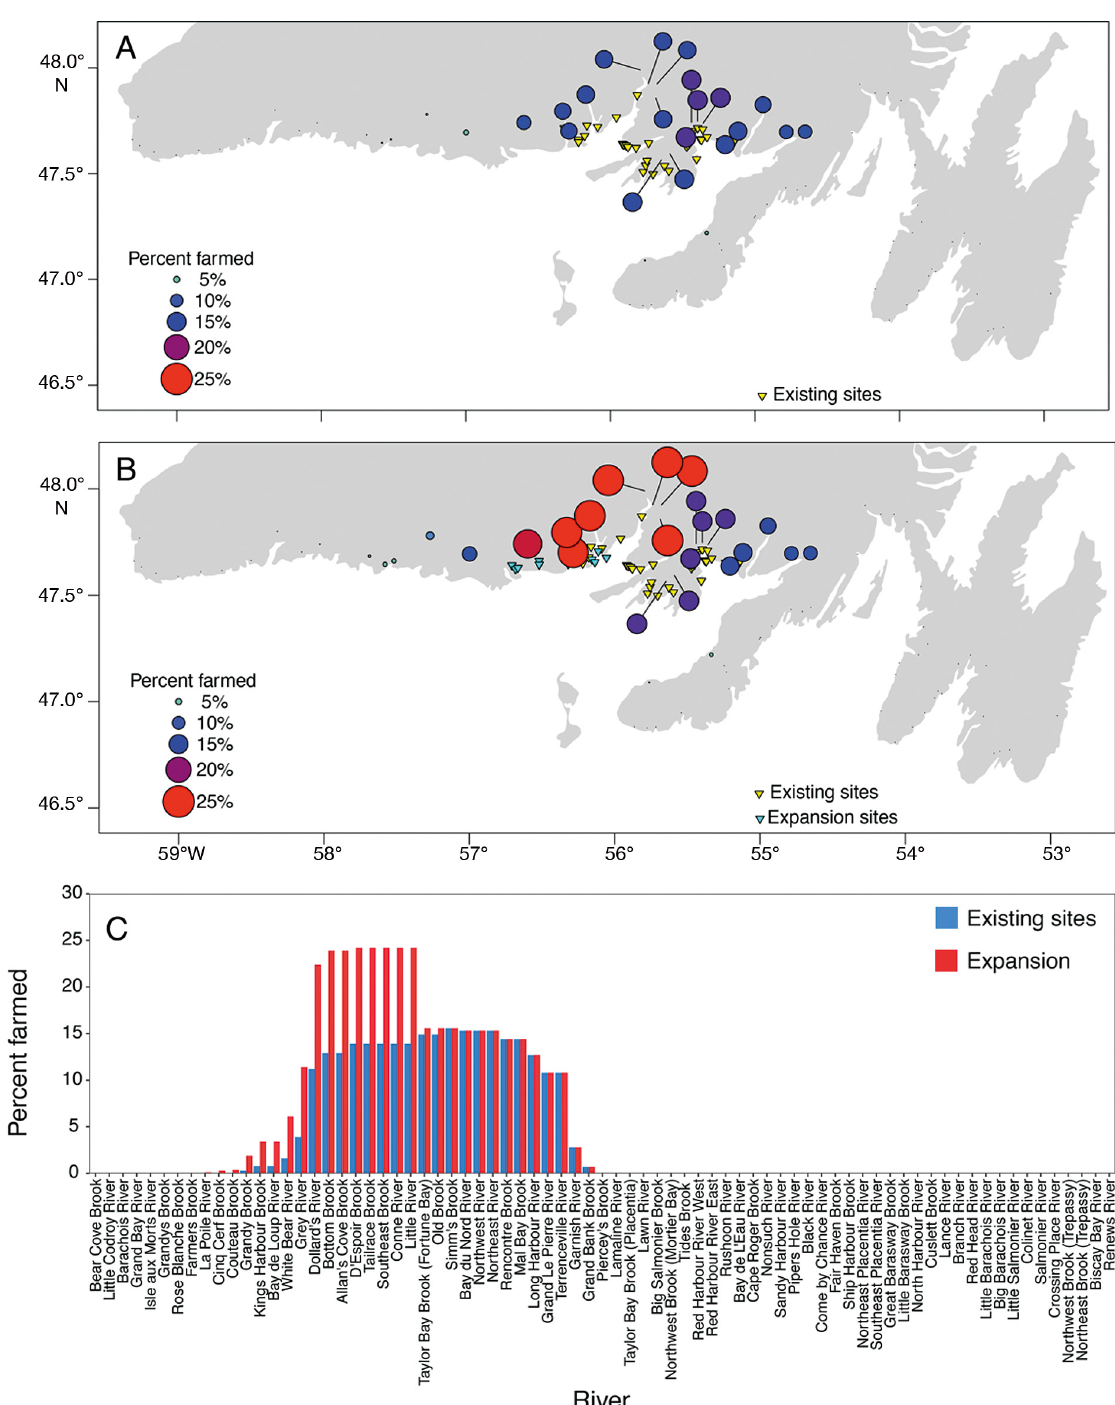
Fig. 6. Predicted spatial distribution and relative percentage of escaped farmed salmon to wild salmon for southern New- foundland under (A,C) the existing production regime and (B,C) the proposed expansion scenario. See Section 2 for (late only) to 970 escapees (early only). For the late (Fig. 7B). Varying the proportion of late escapees re- escapees only scenario, escapees were also distrib- sulted in numbers of escapees in rivers ranging from uted across more locations with higher percentages 1265 to 2565 (Fig. 7C). However even under the low- of escapees compared with only early escapees est probability examined (e.g. 0.06), 14 rivers were